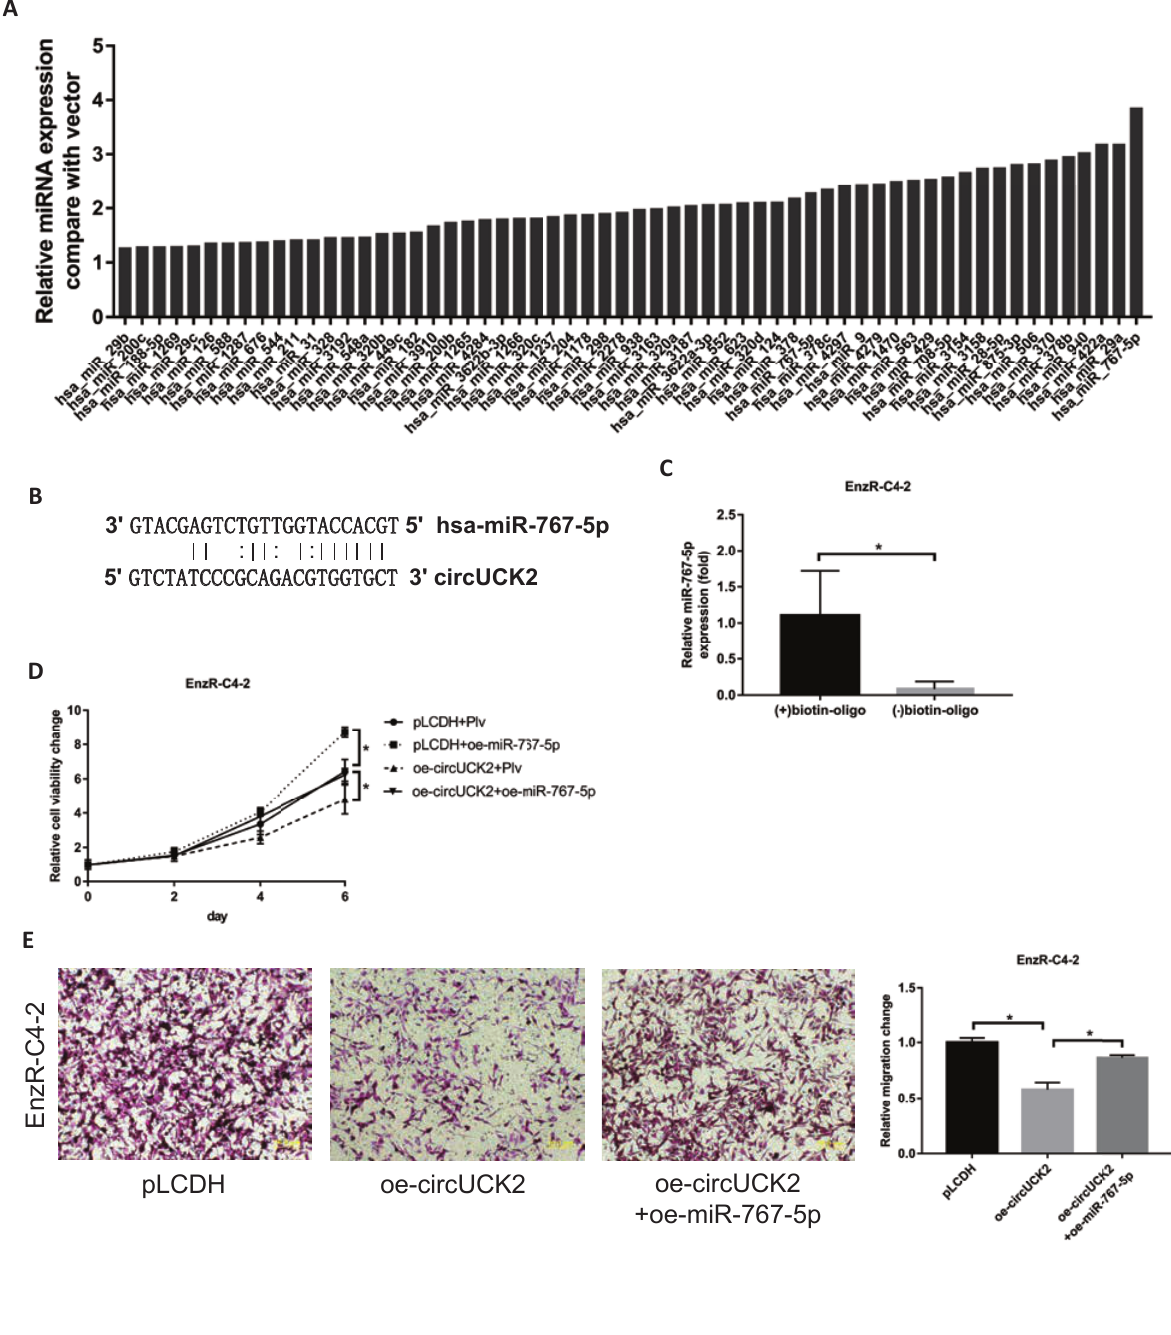
Fig. 2 Mechanism dissection of how circUCK2 can suppress PCa cell growth: via sponge the miR-767-5p